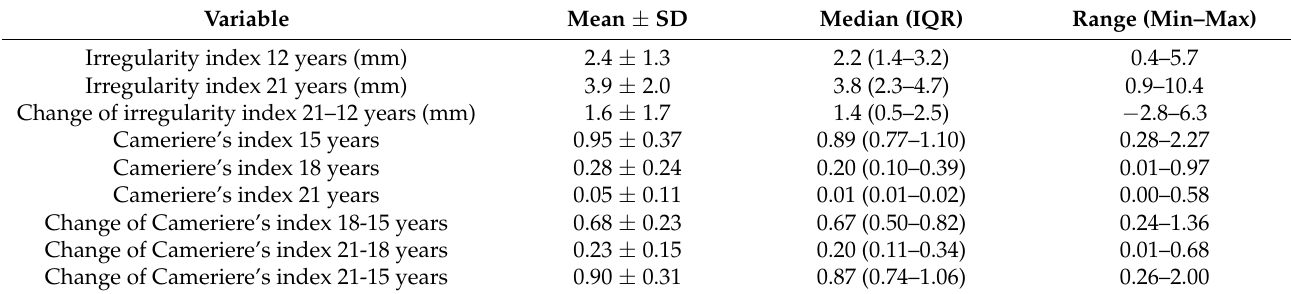
Table 1. Descriptive statistics of the